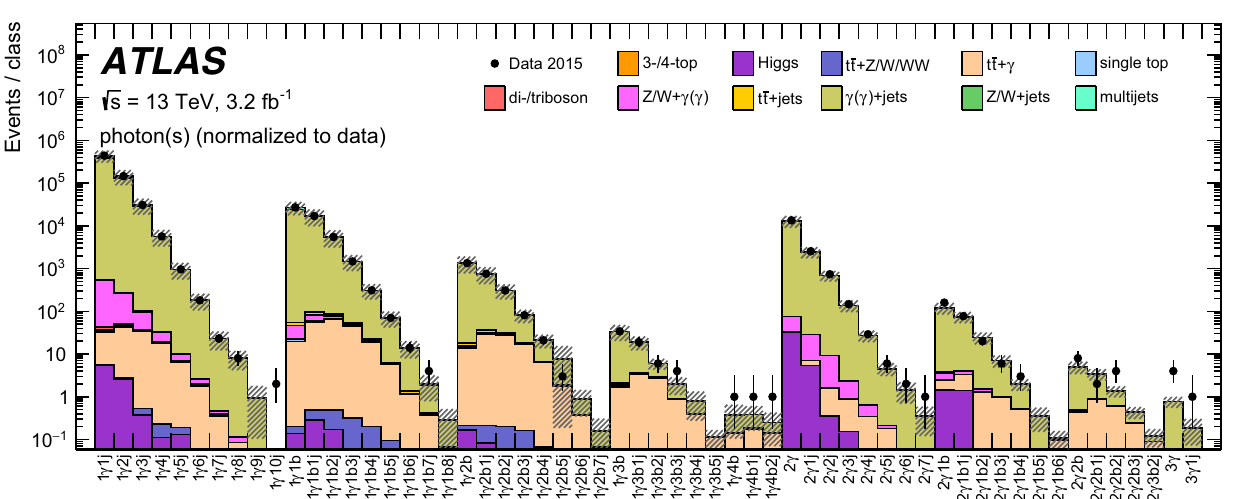
) of the reconstructed objects multiplicity and type ( e , μ , γ , j , b , E miss T for the given event class. The hatched bands indicate the total uncer- tainty of the SM